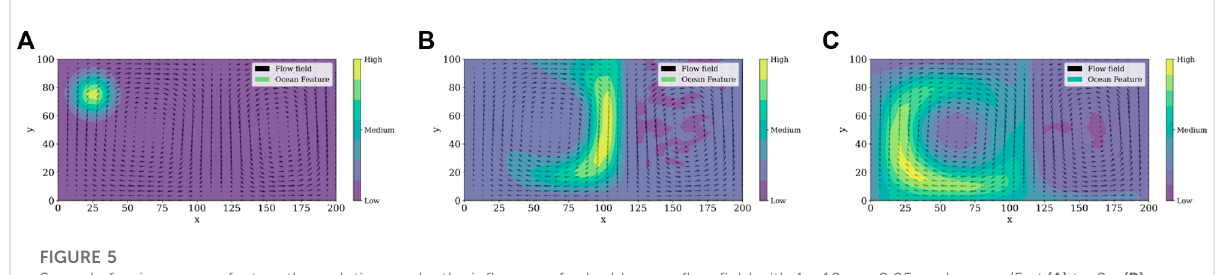
FIGURE 5 Spreadofagivenoceanfeaturethroughtimeunderthein fl uenceofadouble-gyre fl ow fi eldwith A =10, μ =0.25,and ω dg = π /5 at (A) t =0 s (B) t = 5 s (C) t = 10 s.